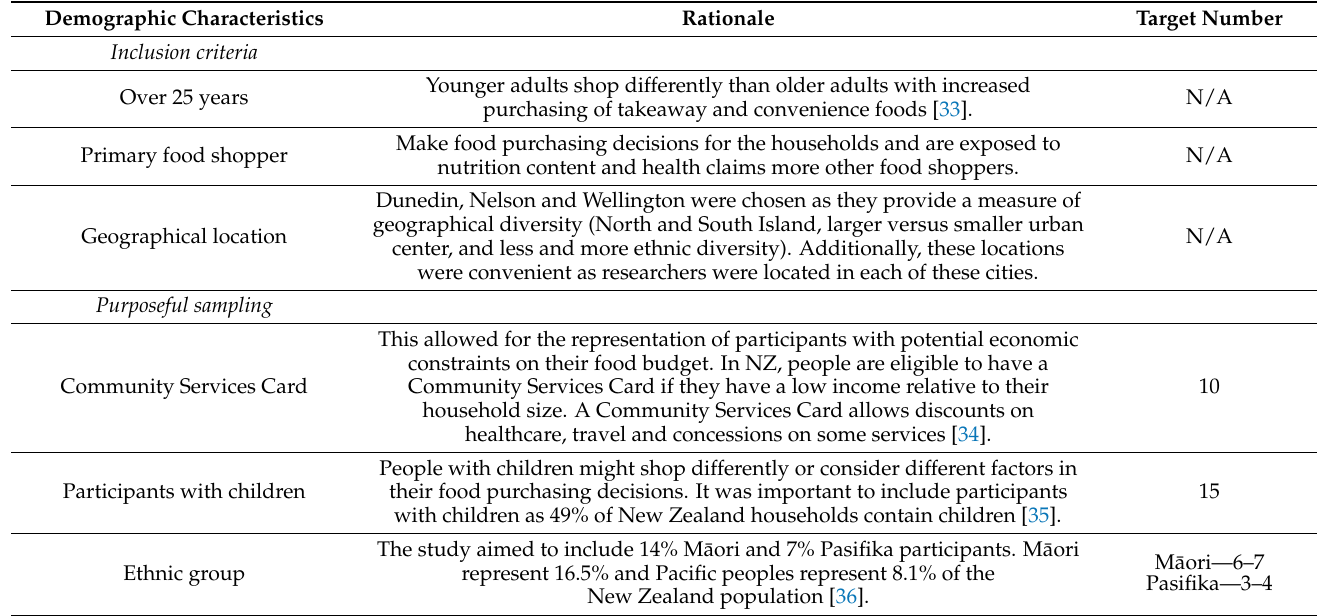
Table 1. Recruitment selection